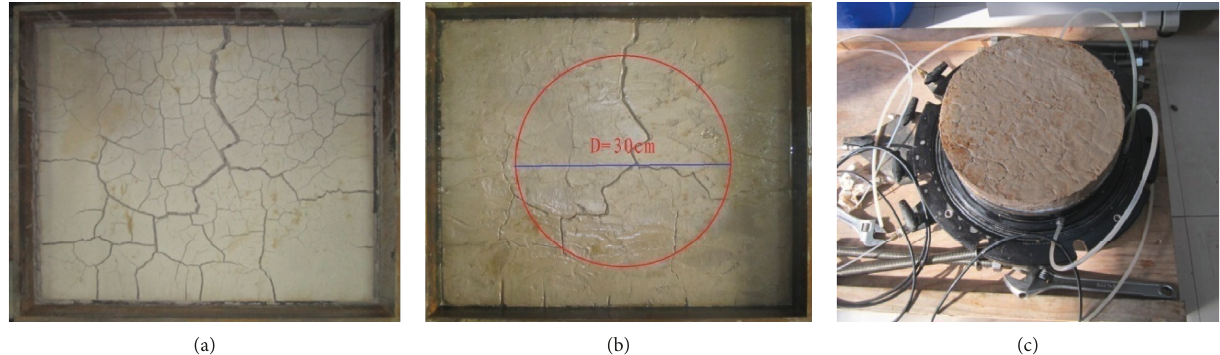
Figure 1: Process of dry-wet cycles and infiltration test: (a) three times drying; (b) saturation again; (c) permeability test.